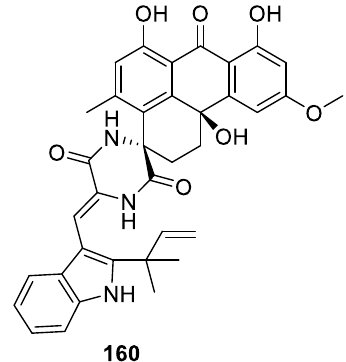
Figure 74. Spirocyclic piperazin-2,5-dione variecolortin B isolated from the marine-derived fungus Eurotium sp. SCSIO F452.